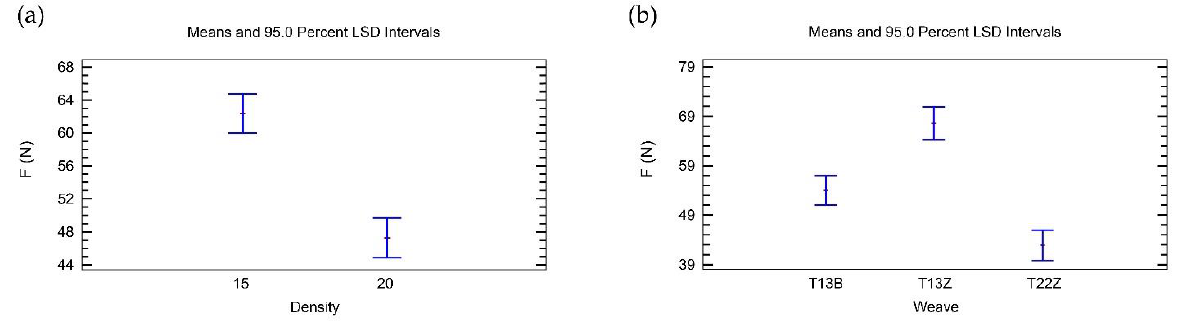
Figure 2. Influence of the main factors on the adhesion force for simple fabrics for z1: ( a ) density; ( b ) weave.